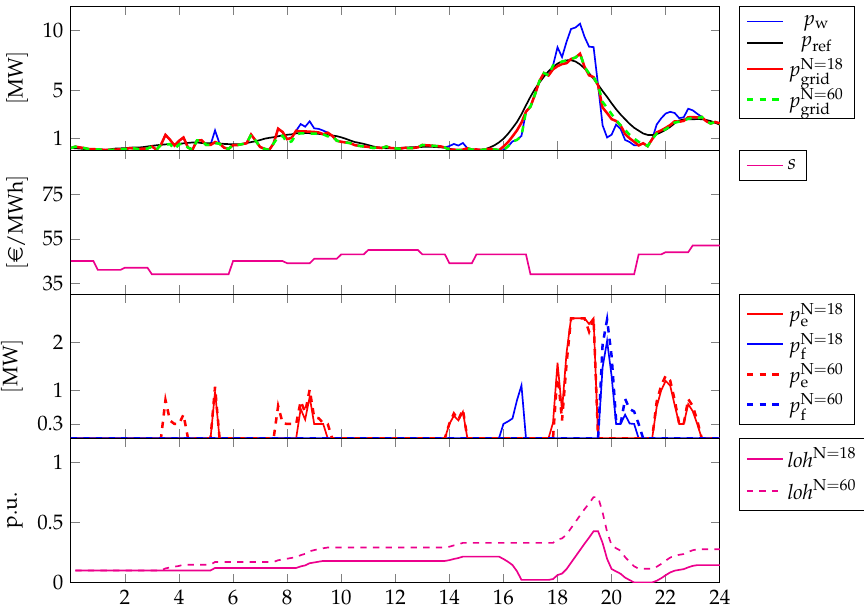
Figure 11. Different profiles related to the reference period from 09:00 of 29 May 2017 to the same hour of 30 May 2017, with full-feature operations: N = 18 vs. N = 60. First graph: power by wind generation (blue solid line), power reference that has to be delivered to the grid (black solid line), actual power delivered when N = 18 (red solid line) and actual power delivered when N = 60 (green dashed line); Second graph: spot market prices s (source: “Gestore dei Mercati Energetici s.p.a. — www.mercatoelettrico.org”); Third graph: power of the electrolyzer when N = 18 (red solid line), power of the fuel cell when N = 18 (blue solid line), power of the electrolyzer when N = 60 (red dashed line) and power of the fuel cell when N = 60 (blue dashed line); Fourth graph: LoH when N = 18 (magenta solid line) and LoH when N = 60 (magenta dashed line).